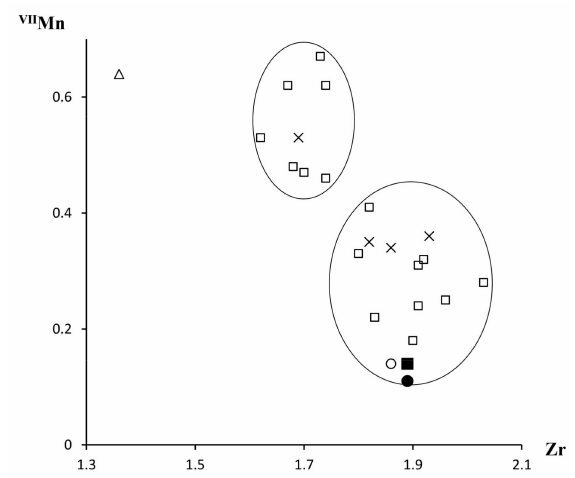
Figure 7. The relationships between the Zr and Mn contents ( apfu ) at the M (2) site of zirconolite-type minerals from the Laach Lake volcano. The correlation coefficient is R = –0.757 for the whole set of analyses, but almost no correlation is observed within Zr-rich (i.e., Mn-poor) and Zr-poor (i.e., Mn-rich) groups of samples separated with ellipses. For legend see Figure 6.